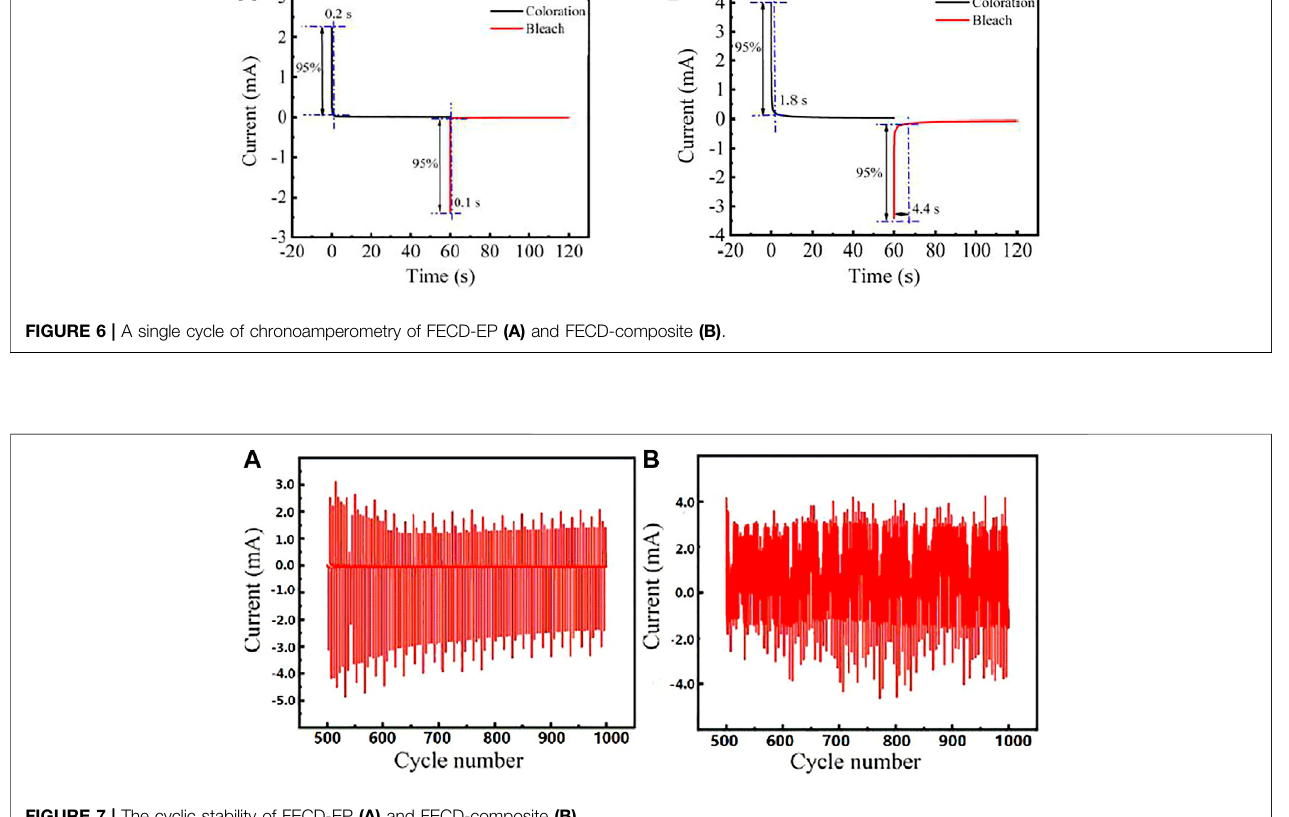
Frontiers in Nanotechnology |